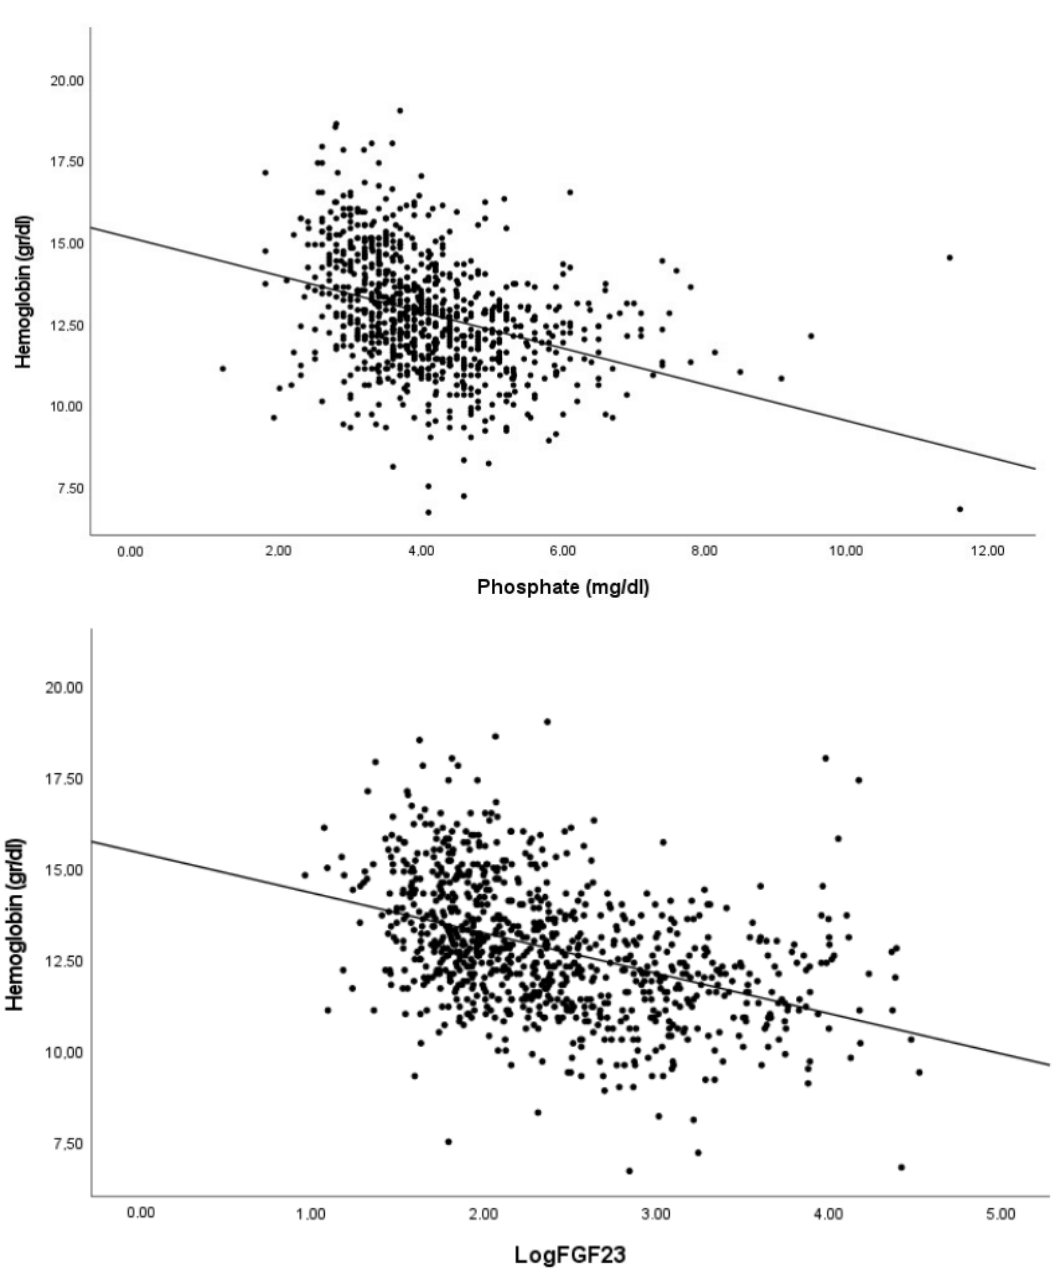
Figure 1. Correlation between hemoglobin levels with FGF23 and phosphate. Pearson’s correlation coefficients − 0.352 and − 0.423 for Log FGF23 and Phosphate respectively. p < 0.001 in both cases.